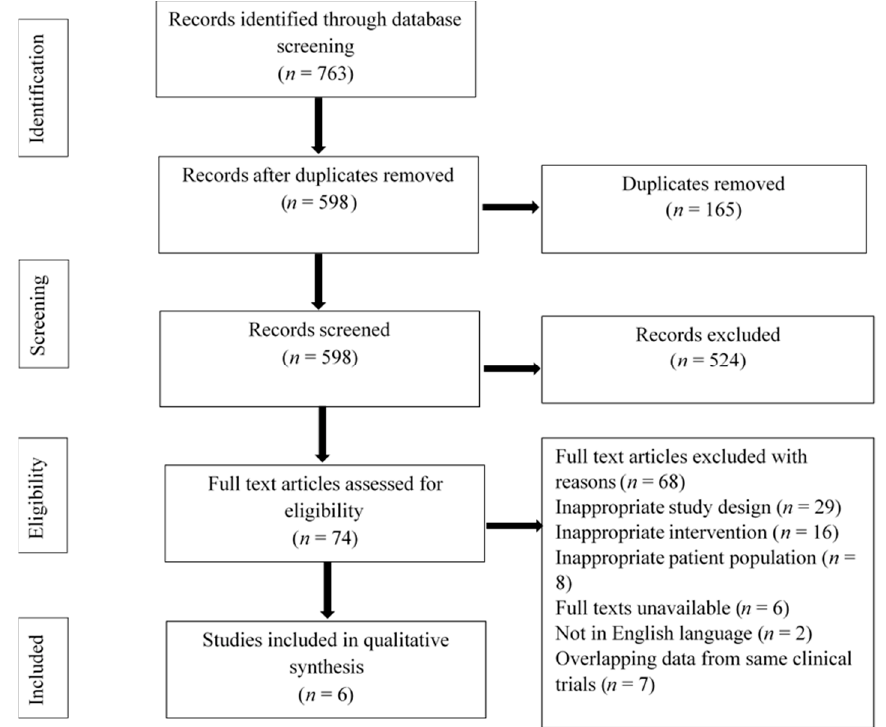
Figure 1. PRISMA flow diagram. Table 2. Narrative summary of included